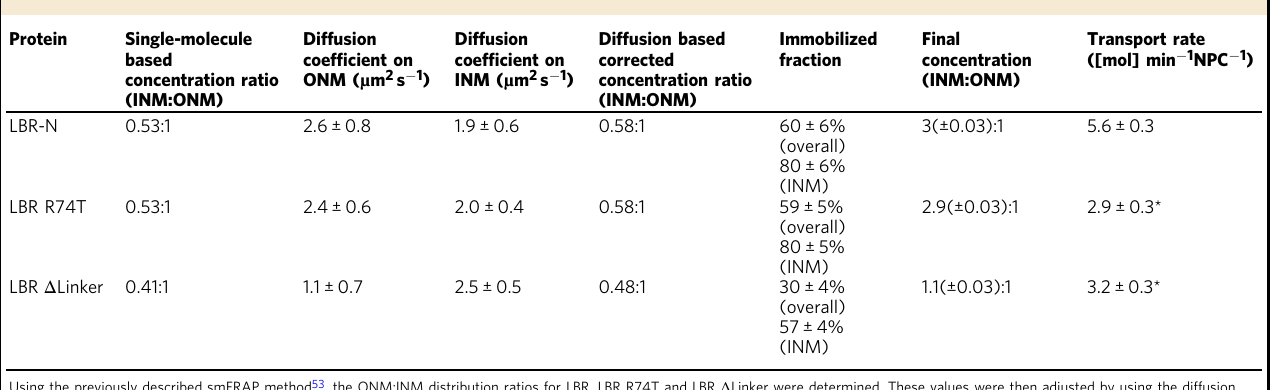
Using the previously described smFRAP method 53 , the ONM:INM distribution ratios for LBR, LBR R74T and LBR Δ Linker were determined. These values were then adjusted by using the diffusion coef fi